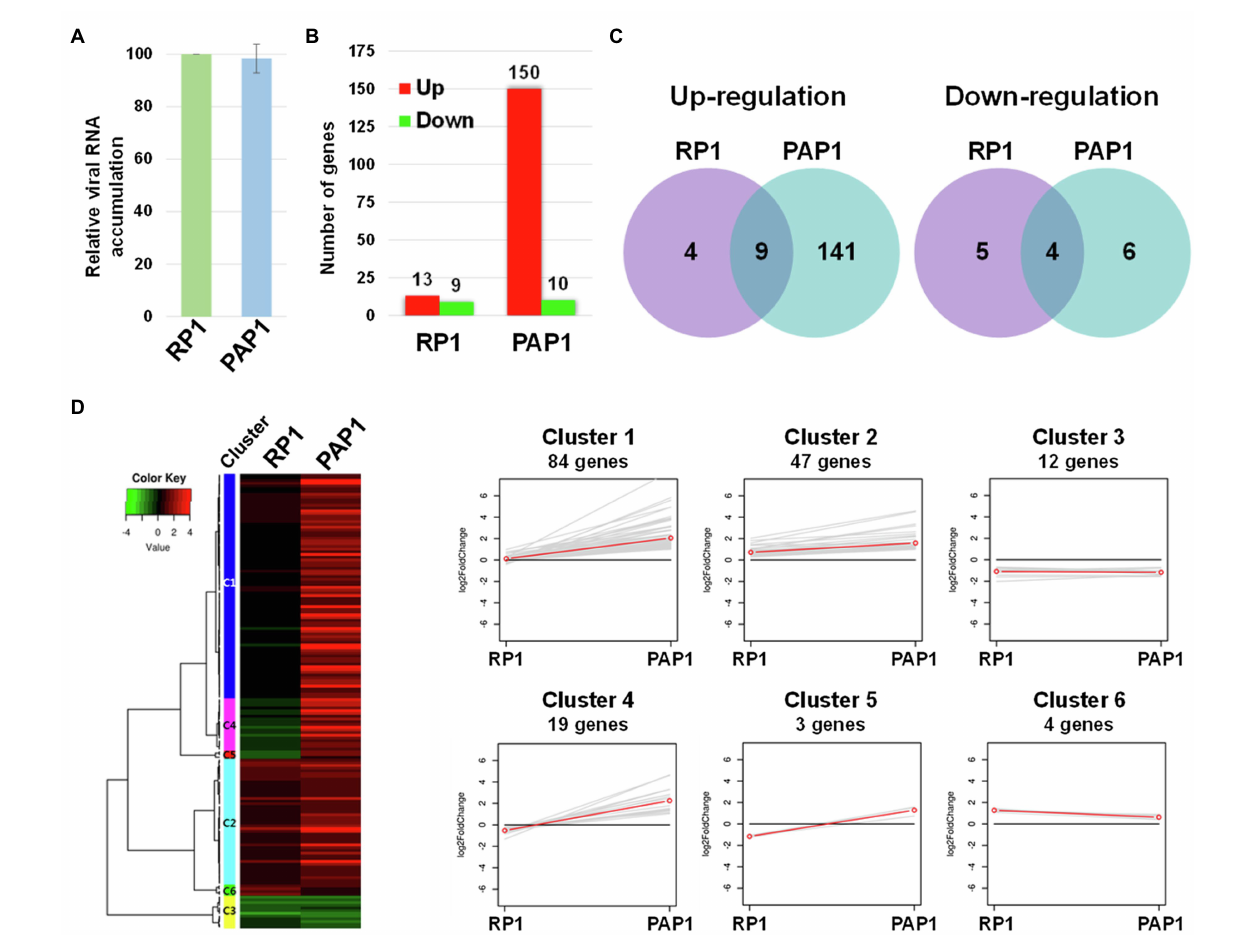
FIGURE 2 | Transcriptome analysis of distinct symptoms induced by two different BBWV2 strains in pepper. (A) Relative accumulation analysis of BBWV2-PAP1 and RP1 in pepper by quantitative real-time RT-PCR (qRT-PCR). Means ± SD from three independent experiments are shown and each column represents one group with nine plants; statistical analysis was performed using paired Student’s t -tests to detect significant differences. (B) The number of DEGs identified by RNA sequencing of the transcriptomes in response to infection with BBWV2-PAP1 or RP1. The DEGs were identified by comparing the virus-infected samples to healthy samples using a 2-fold change in expression with a false discovery rate (FDR) of ≤ 0.01. Red and green bars indicate the numbers of up and downregulated DEGs, respectively. (C) Venn diagrams display the number of up or downregulated DEGs upon infection with each virus strain. (D) Hierarchical clustering of the identified DEGs. The heat-map was produced using a log scale of the fragments per kilobase of exon per million fragments mapped (FPKM) data obtained by RNA Sequencing. Red and green indicate up and downregulation, respectively. The linear graphs show the expression patterns of each cluster.